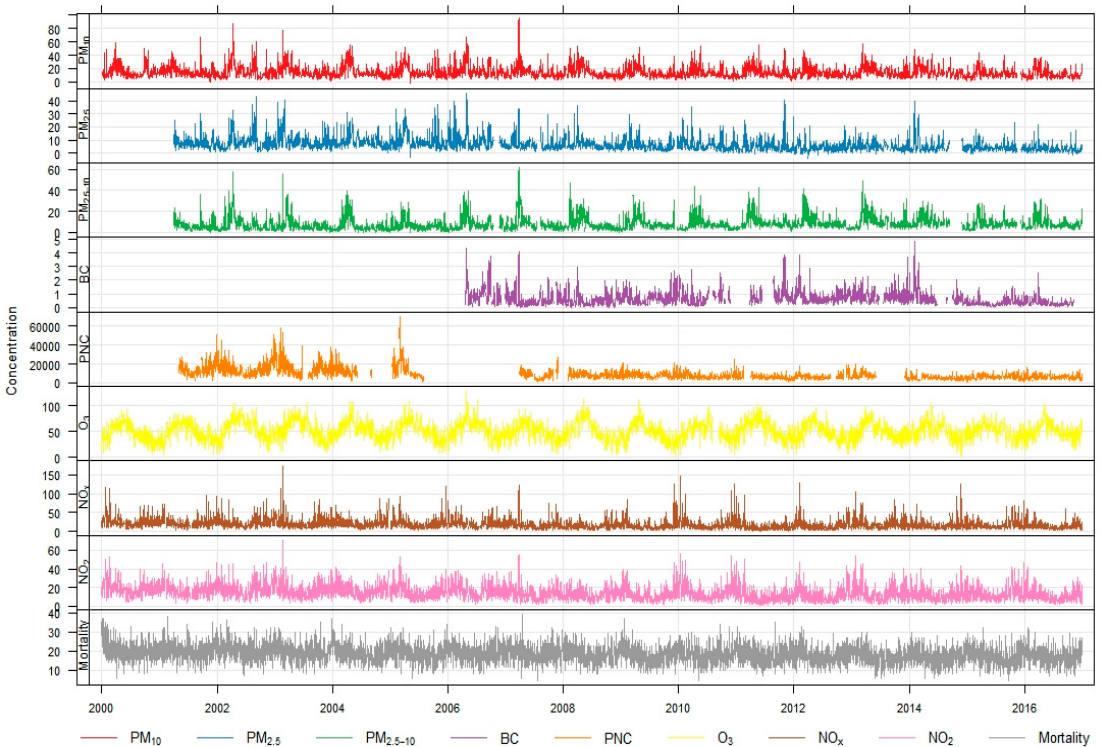
Figure A1. Daily mean concentrations of PM 10 , PM 2.5 , PM 2.5–10 , BC, O 3 , NO x and NO 2 ( μ g m − 3 ), and total particle number count (PNC) (>4 nm, cm − 3 ), and the daily number of deaths in Stockholm during the period 2000–2016.